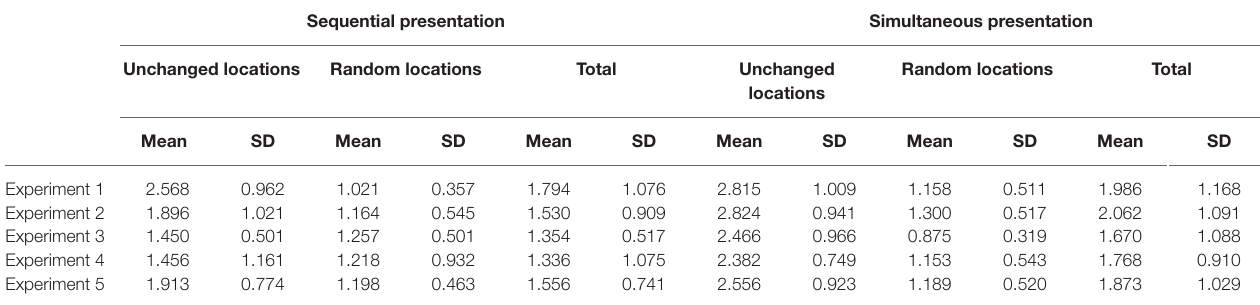
TABLE 1 | Mean d prime scores in all experimental conditions in the five experiments.